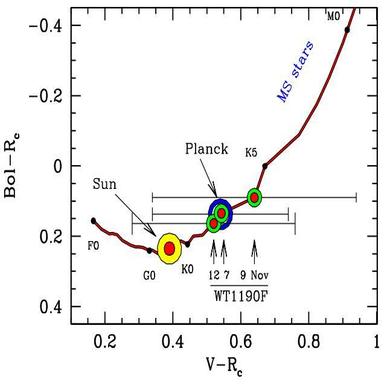
The reference framework of Fig. 15 is replied here to assess the bolometric correction to the Rc band. The average ðV RcÞ color of WT1190F along the three observing nights of 2015 November intercepts the stellar calibration to derive a confident estimate of the bolometric correction about ðBol RcÞ 0:130:05 mag. Note, again, the close match of WT1190F with the Planck deep-space probe. (For interpretation of the references to color in this figure legend, the reader is referred to the web version